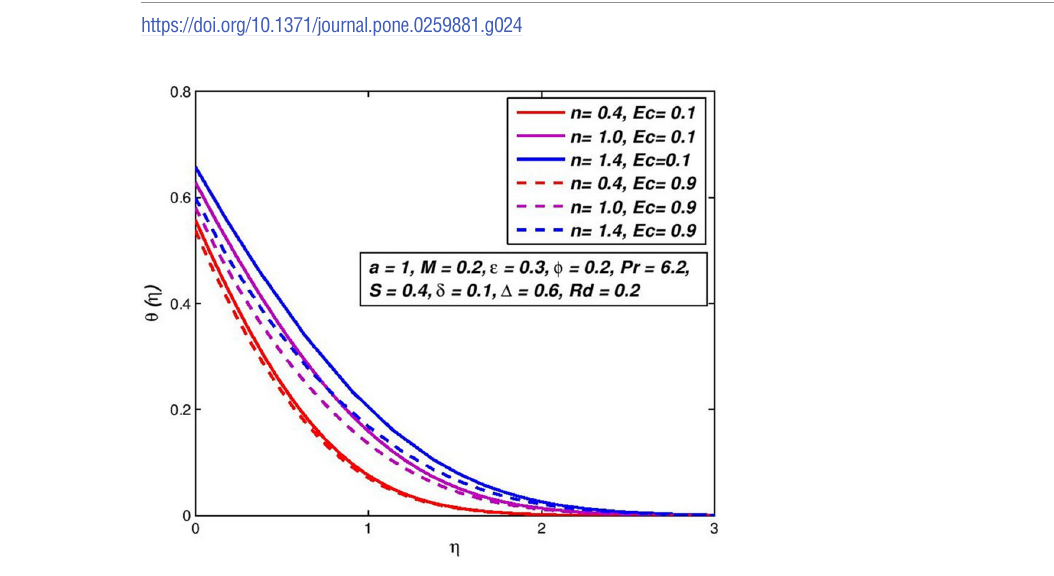
Fig 25. Effect of Ec on θ ( η ) for diverse n